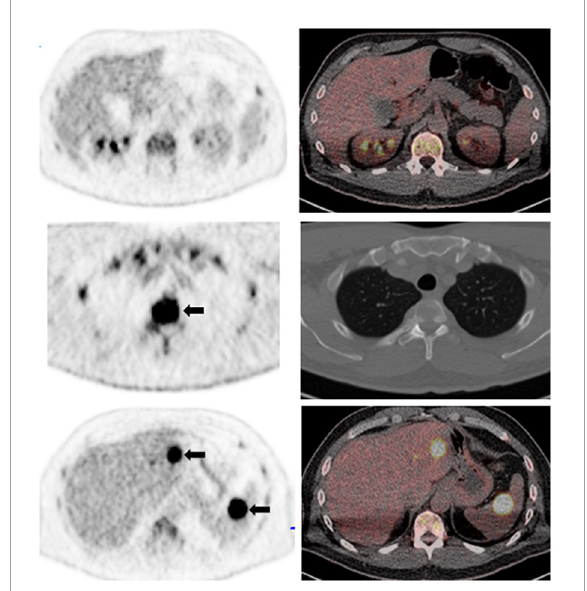
FIGURE3 A 62-year-old man with a history of oligosecretory multiple myeloma. Whole body maximum intensity projection PET image (not shown) showed diffuse increased FDG uptake in the bone marrow above background liver (bone marrow Deaville score, 4). Representative axial PET (left column) and fused PET/CT images (right column) show diffuse increased bone marrow activity above liver (top row) ; and intensely metabolically active skeletal lesions (T3 vertebral body; arrows, middle row ). There are also multiple metabolically active extraskeletal focal lesions with intense FDG uptake in the liver and spleen (arrows, bottom row) ; focal lesion Deauville score, 5.